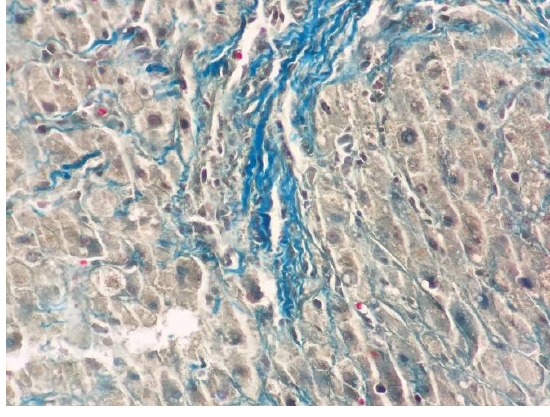
Figure 5. Liver biopsy showed diffuse fibrosis and few metachromatic mast cells. (Trichrome, 400×)